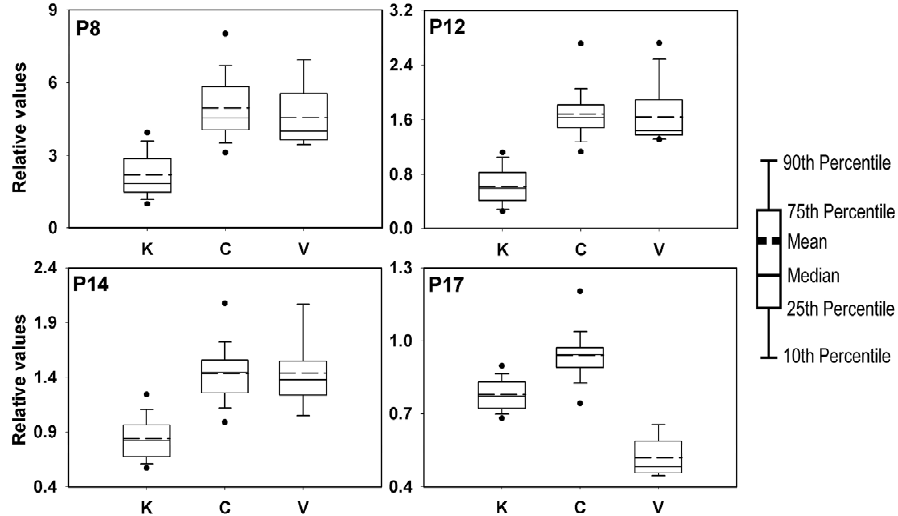
Figure 3. Box plots for variables that are highly correlated with the canonical discriminant func- tions (K = Korean, C = Chinese, and V = Vietnamese). The dots indicate the 5th and 95th percen- tiles.